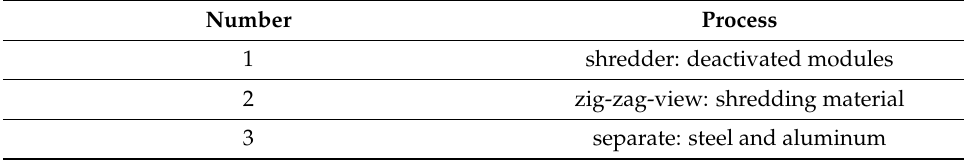
Table A16. Activities of the main application process “recycling”: aluminum and steel.